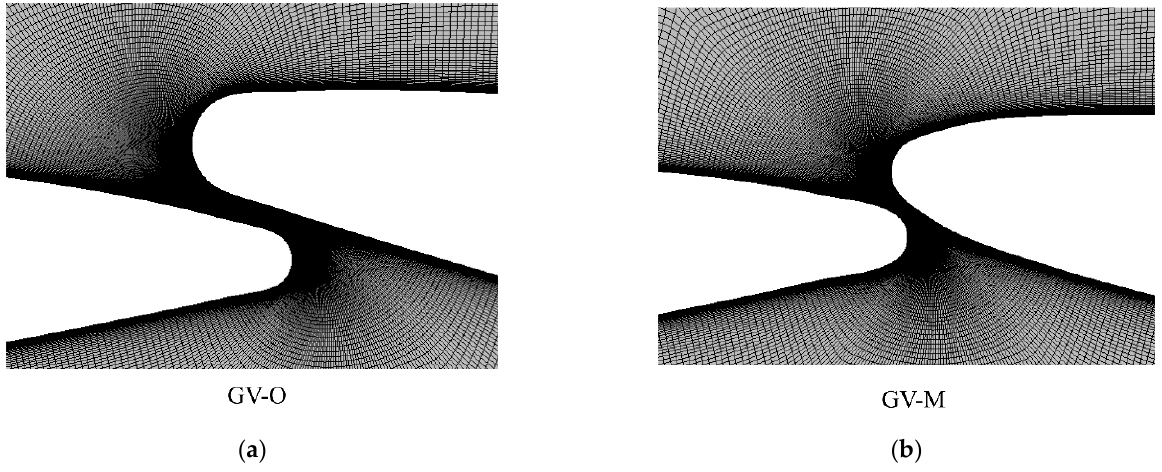
Figure 9. Schematic map of the mesh used in 2D coupling simulation. ( a ) GV-O; ( b ) GV-M. Table 3. Grid convergence analysis based on the flow rate coefficient C φ for 3D CFD simulations and the damping ratio ζ α for 2D coupling simulations at α = 0.2° and C ψ = 1.133. Item Value in 3D Case